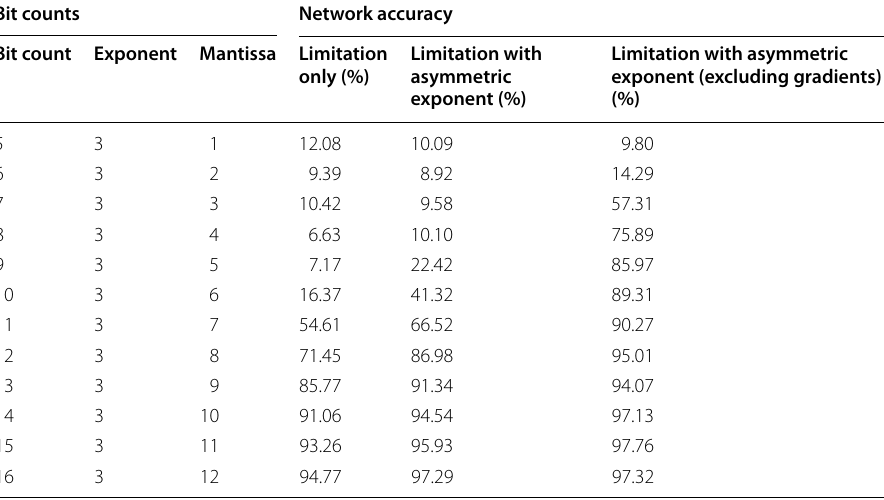
Table 3 Comparison of neural network accuracies with 3-bit exponent Bit counts Network accuracy Bit count Exponent Mantissa Limitation